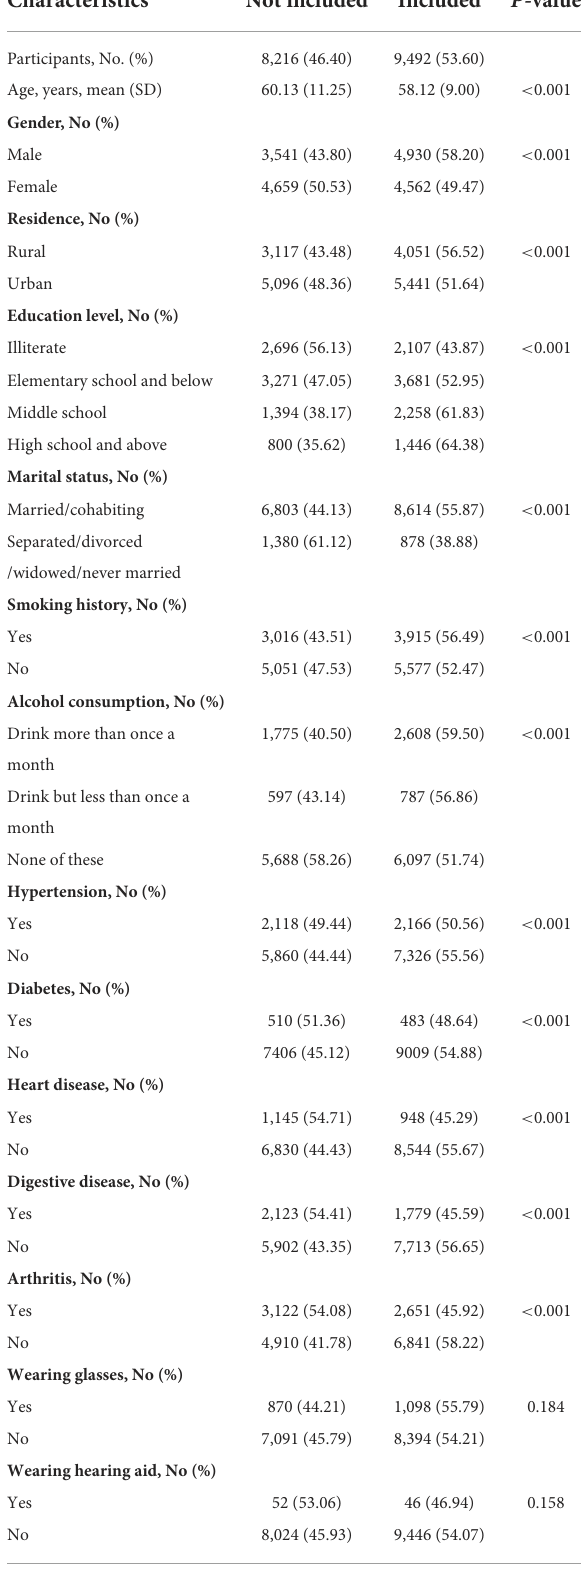
TABLE 2 The characteristics between participants included and not included at